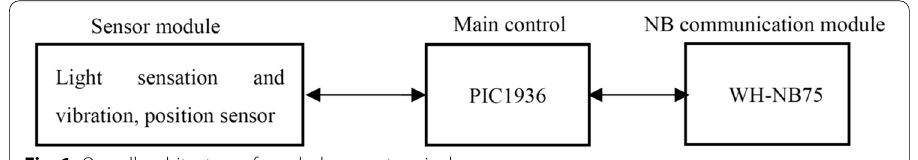
Fig. 1 Overall architecture of manhole cover